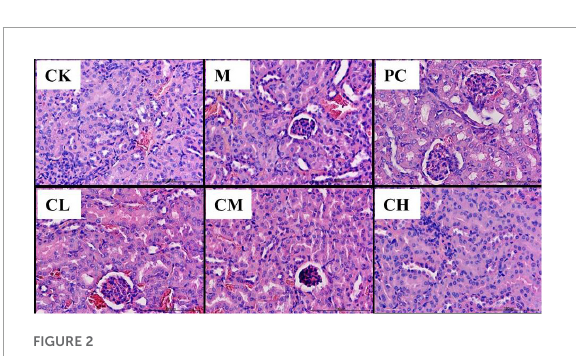
FIGURE2 Histopathological changes in the kidney (HE, 200 × ).